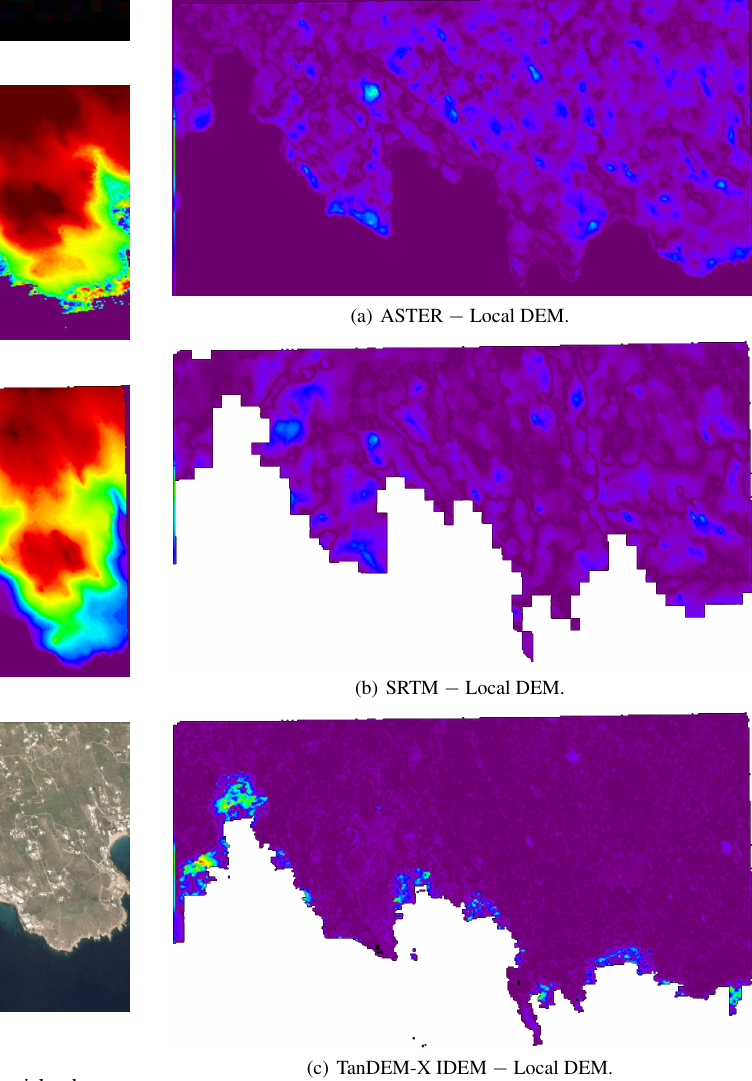
Figure 7. Psarrou study site. The elevation differences between global DEMs and local DEM.